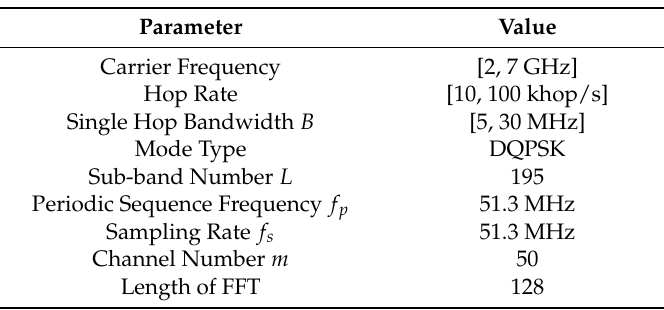
Table 1. Simulation